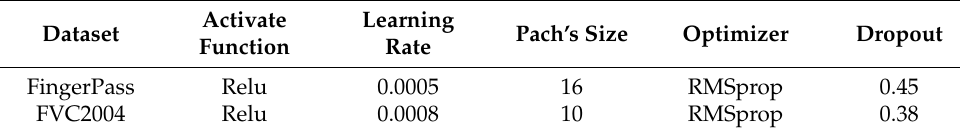
Table 1. The optimized hyperparameters using Optuna